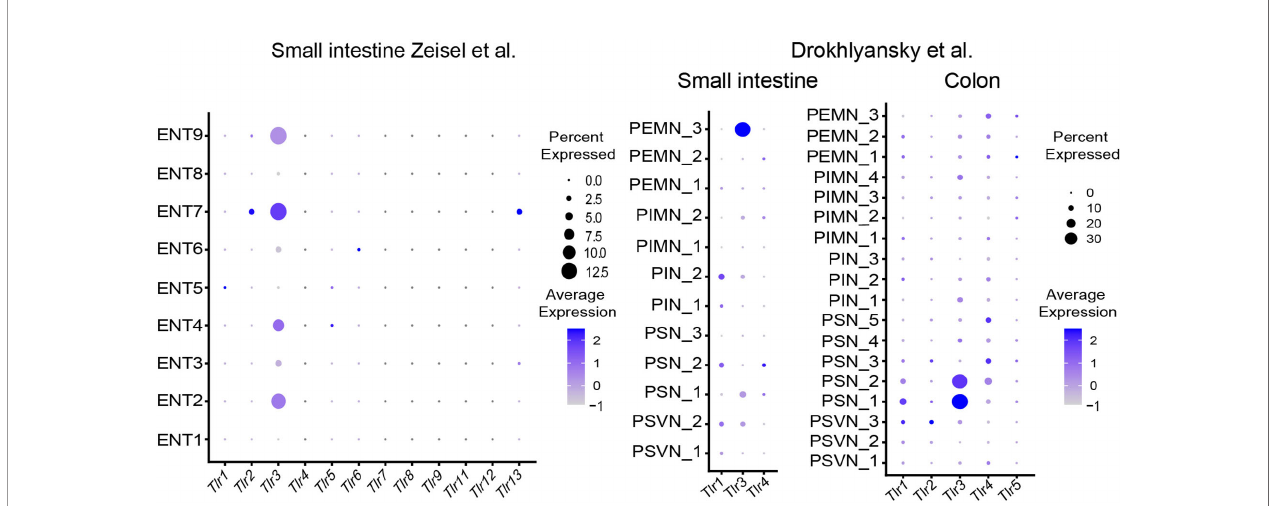
FIGURE 4 | Expression of Toll-like receptors in different ENS subsets. Dotplots showing the percentage of expressing cells as well as average expression within the indicated identi fi ed neuronal clusters for selected murine Toll-like receptor genes. Data was downloaded from http://mousebrain.org/ (12) or from https://singlecell. broadinstitute.org/ (14). Genes not present in the plot showing the Drokhlyansky data have been fi ltered. All dataset were normalized and transformed before the plots were created using the Seurat package